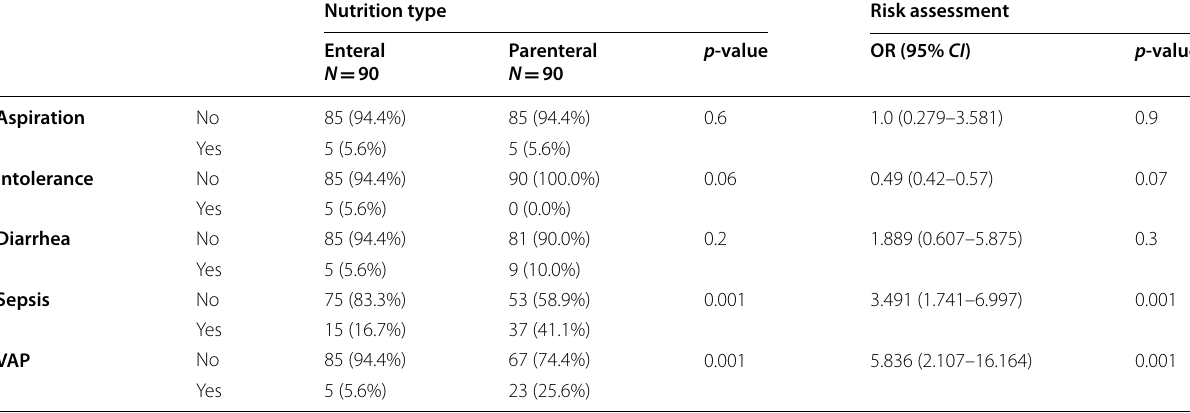
Complications are represented as frequency and percent; the data were analyzed by Χ 2 test